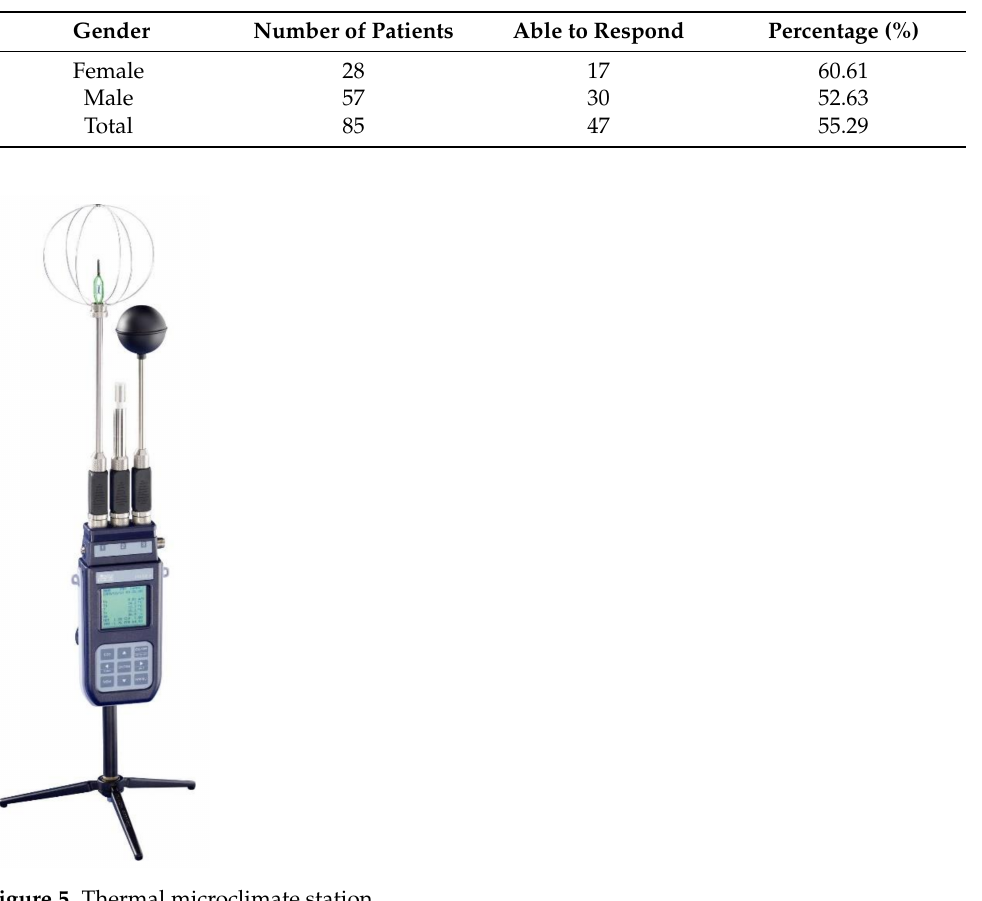
Figure 4. Subjective measuring tool. Table 2. Summary of patients’ ability to answer the questions.